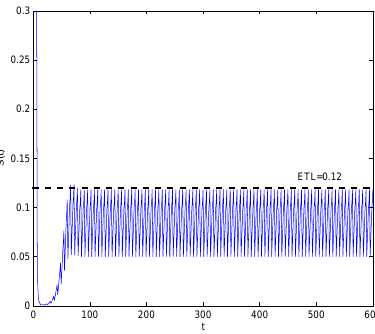
Figure 5. Time series of pests. Pests can be controlled under